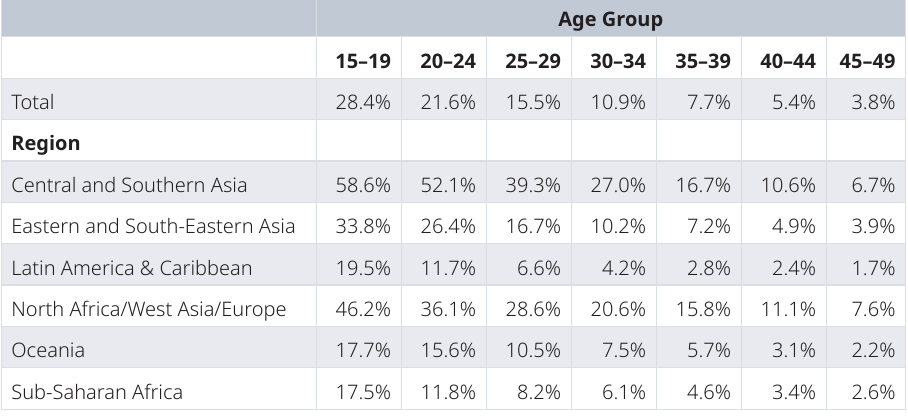
Table 2. Proportion of married women living with their mother-in-law by age group.